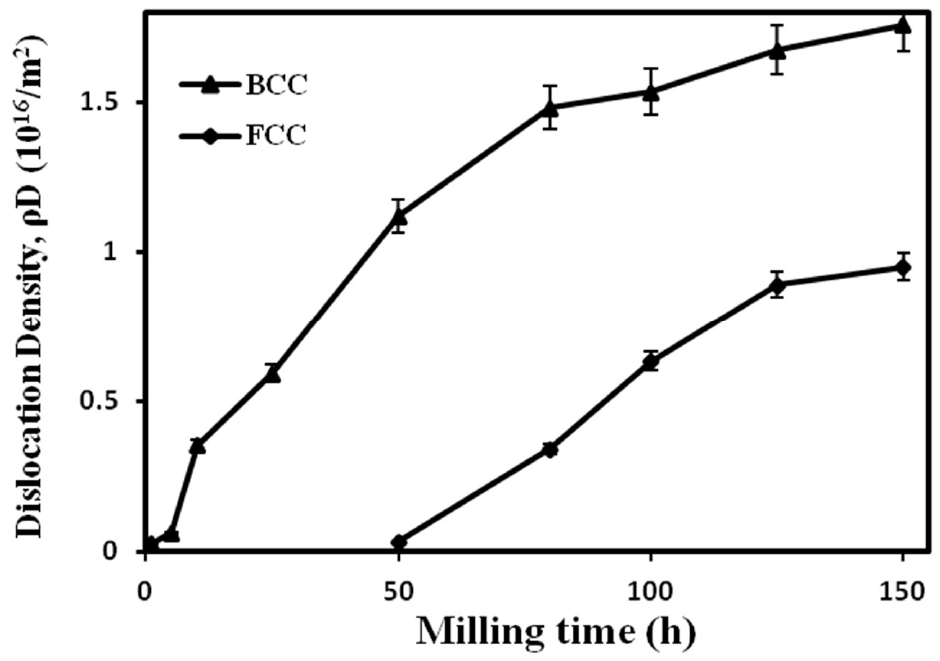
Figure 6. Variation of dislocation density as a function of milling time. For the FCC phase, a drastic increase is observed from about 0.030 × 10 16 /m 2 at 50 h to 0.89 × 10 16 /m 2 at 125 h. At the end of the milling, the ρ D slightly increases, reaching 0.95 × 10 16 /m 2